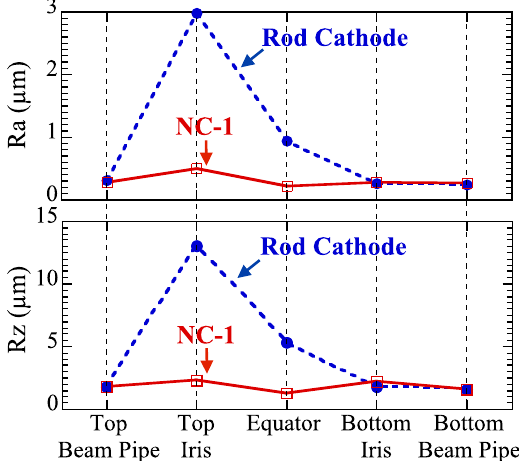
FIG. 10. Roughness Ra (up) and Rz (down) of coupons after VEP was performed with the rod cathode and NC-1.